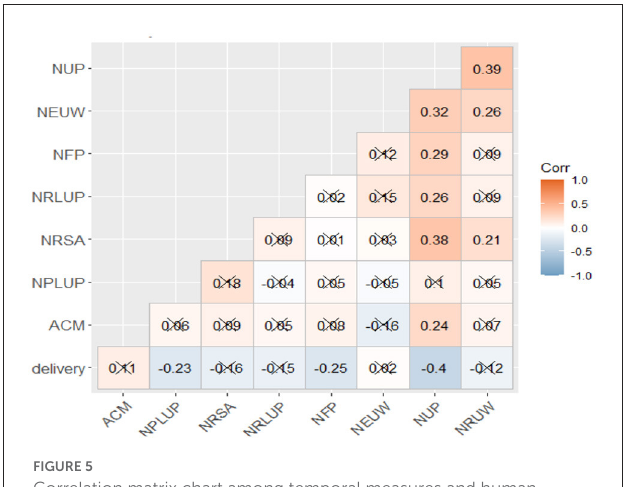
FIGURE5 Correlation matrix chart among temporal measures and human assessment for delivery.